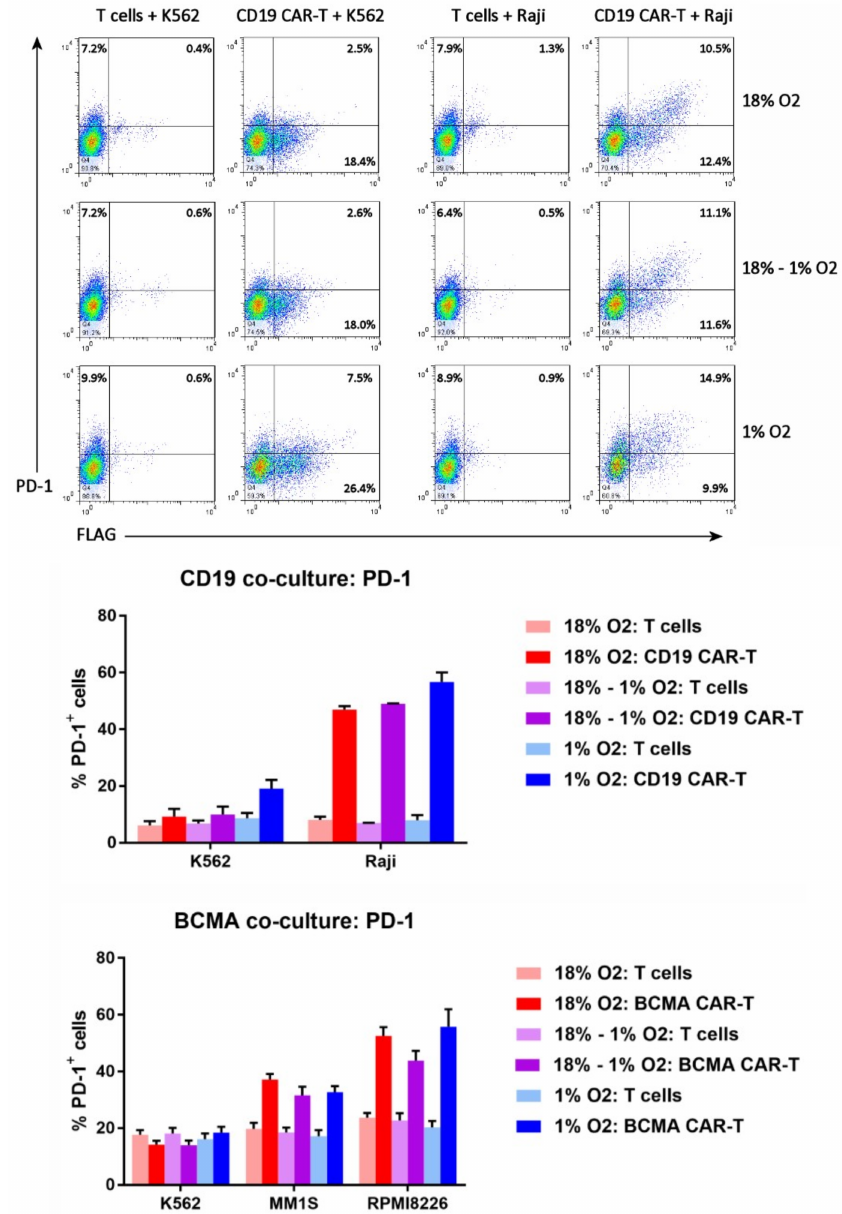
Figure 8. Hypoxia does not a ff ect CAR-T cell PD-1 upregulation. Top: the cells from the CD19 CAR-T cell co-cultures were analyzed by flow cytometry for FLAG staining (i.e., CD19 CAR expression) vs. PD-1 expression. Bottom: the percentages of CD19 CAR-T cells, BCMA CAR-T cells, or control T cells expressing PD-1 were plotted; data-points represent the average and standard error of 2–4 separate